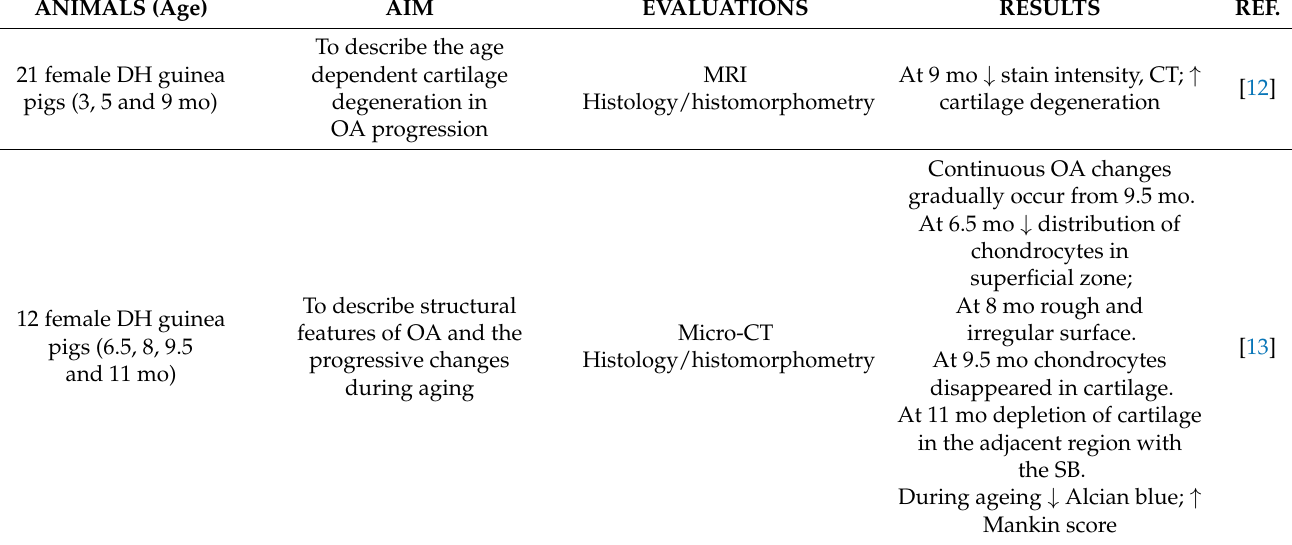
Table 1. Preclinical in vivo studies evaluating naturally occurring OA in guinea pigs. AIM EVALUATIONS RESULTS